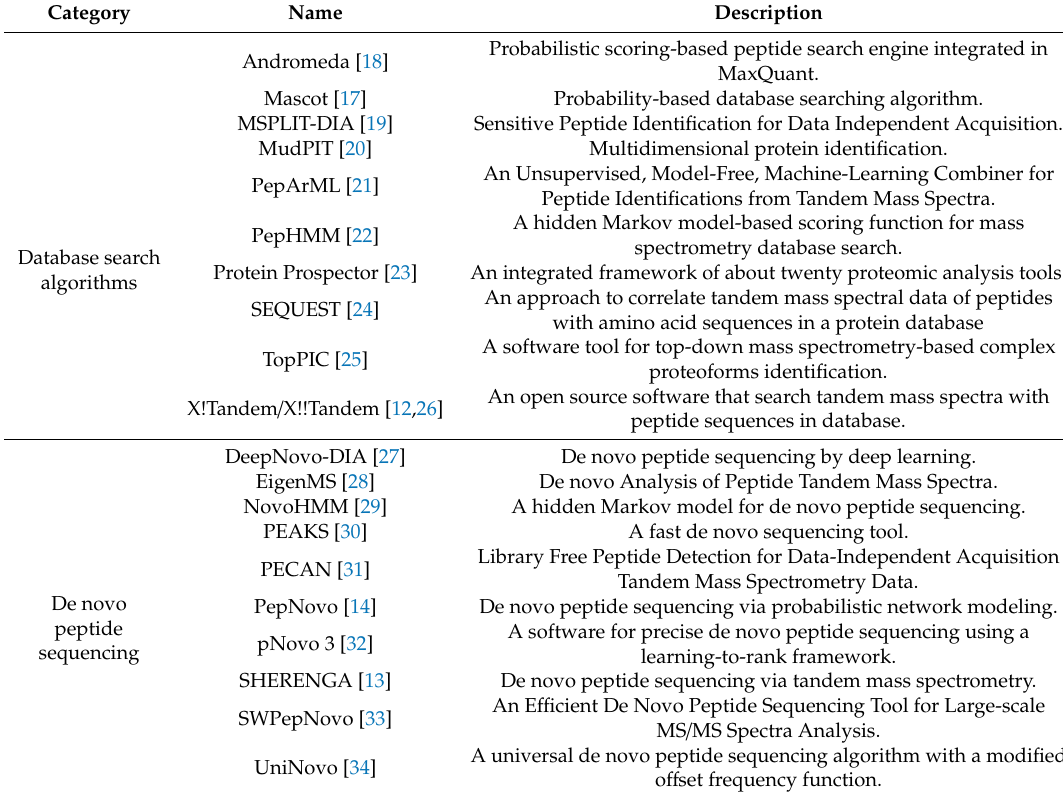
Table 1. Commonly used software packages for peptide and protein